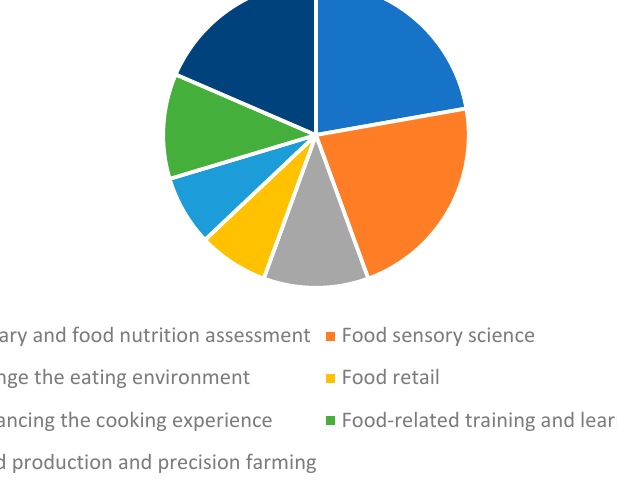
Figure 1. The proportions of AR HMDs used in the seven application categories.